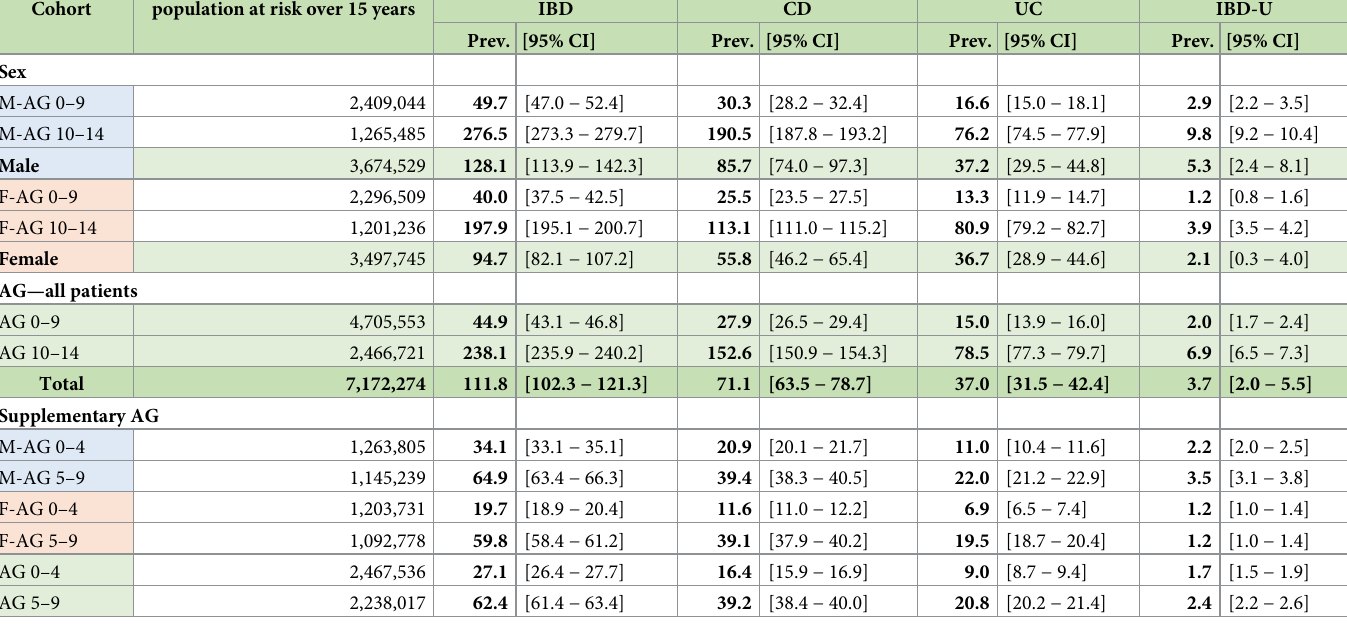
Table 2. Age-standardized 15-year prevalence (Prev.) (sex and age specific) of inflammatory bowel disease (IBD), Crohn’s disease (CD), ulcerative colitis (UC) and unclassified IBD (IBD-U) per 100,000 in